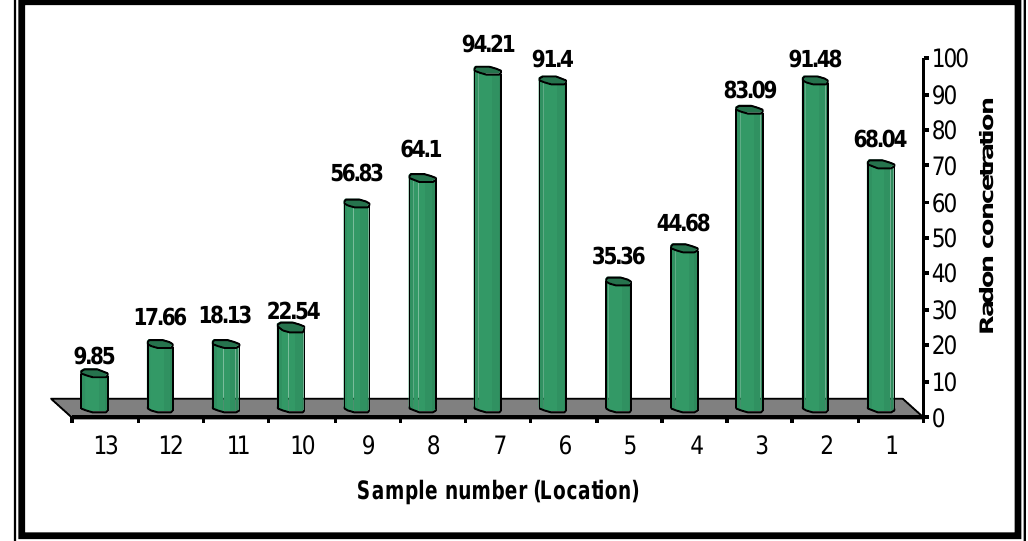
Fig. 3: A histogram illustrating the change in radon gas concentration in indoor rooms in science college buildings in the university of